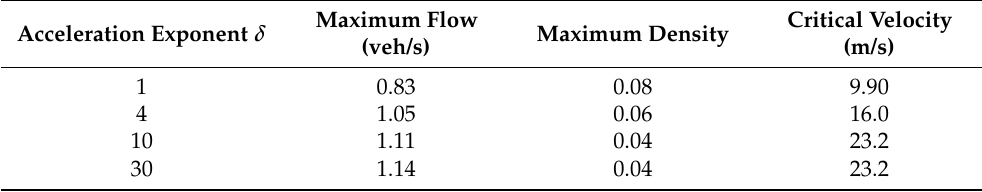
Figure 5. Flow and velocity of the ID and proposed models. Table 3. Maximum flow, density, and critical velocity for the ID model.